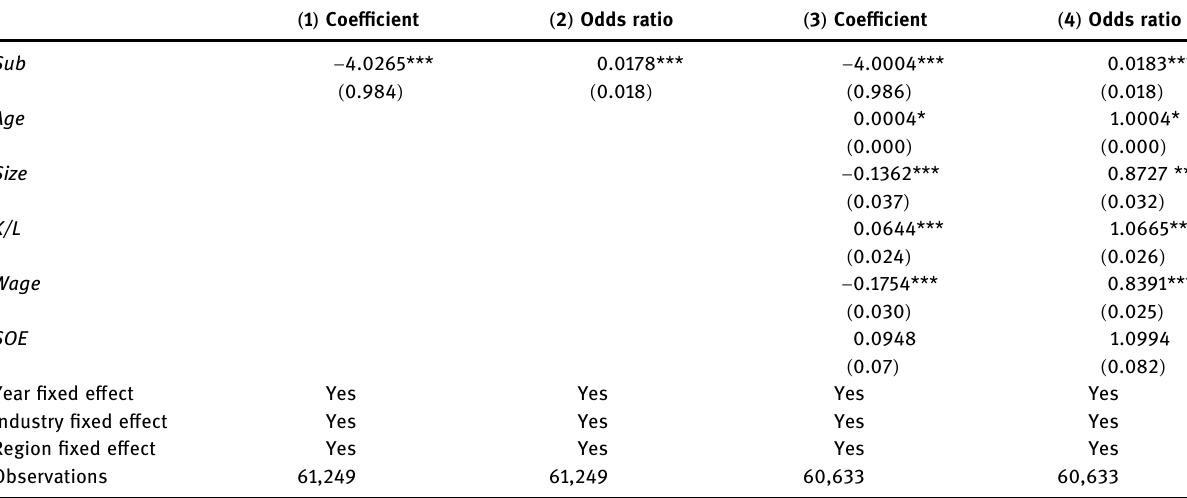
Table 11: Impact of fi scal subsidies on zombie fi rms ’ resurrection probability ( 1 ) Coe ffi